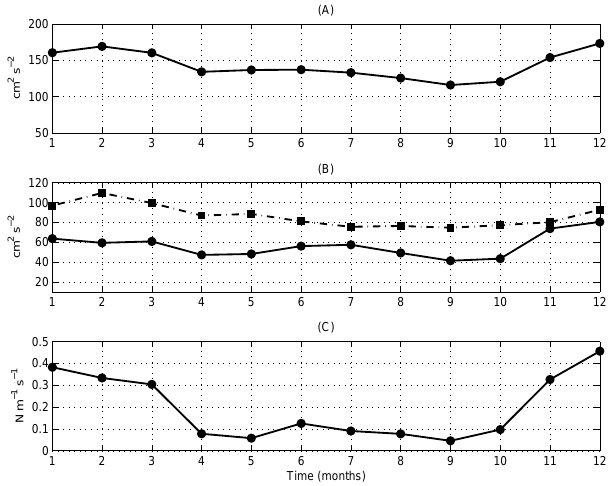
Fig. 4. Time series of: monthly mean TKE (panel A , [cm 2 s − 2 ]); MKE – solid line – and EKE – dashed line – (panel B , [cm 2 s − 2 ]); Wsw (panel C , [Nm − 1 s − 1 ]). All time series has been averaged overall the model domain, vertically integrated from surface to 5 m depth and on the period 2008–2010.